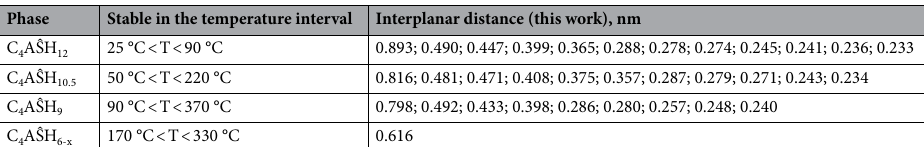
Table 1. Thermal stability of different hydration states of calcium monosulfoaluminate states.